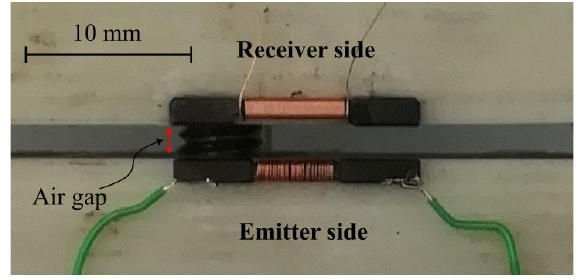
Figure 8. Wireless power transfer device under analysis.